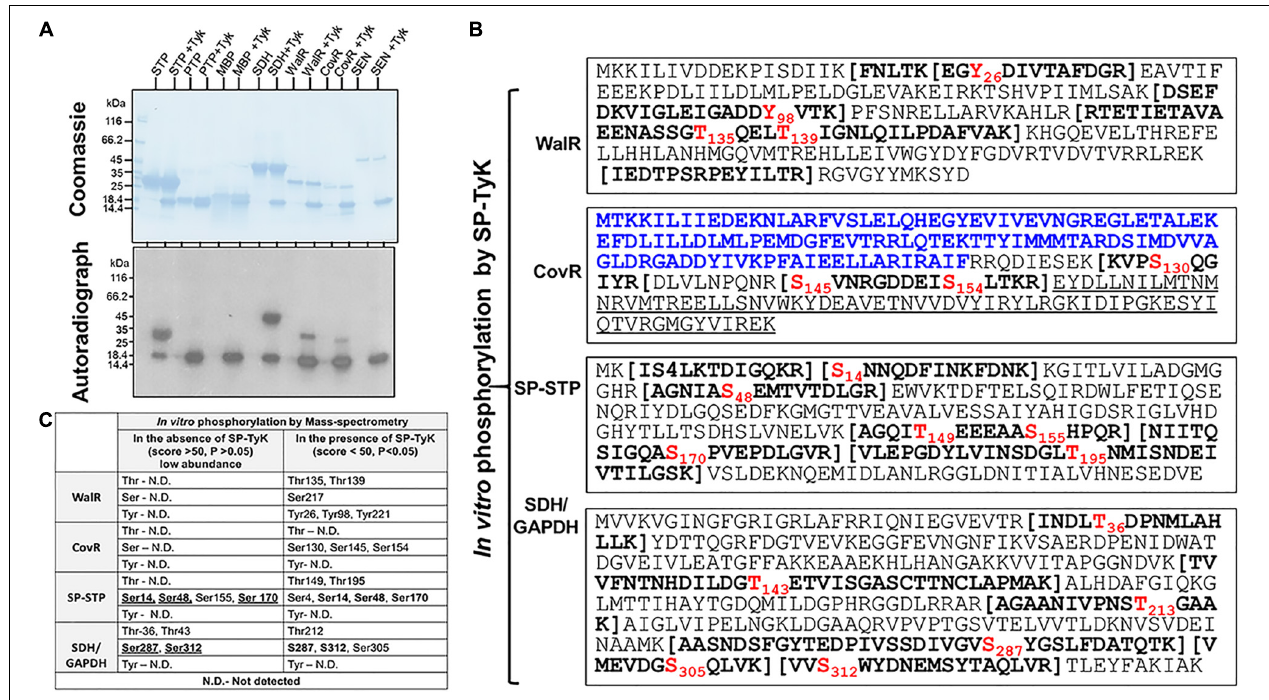
FIGURE 5 | SP-TyK-targeted in vitro substrates and their specific amino acid residues identification and biological relevance. (A) Identification of substrates by examining kinase activity of SP-TyK. SDS-PAGE-resolved individual proteins (SP-STP, SP-PTP, MBP, SDH, WalR, CovR, and SEN 1 µ g each) and corresponding autoradiographs show in vitro phosphorylation (as described in Figure 2 ) in the presence and absence of SP-TyK (Tyk, 0.6 µ g/reaction). Coomassie-stained SDS-PAGE gel with resolved protein bands depicts loading control for each protein. The corresponding autoradiograph shows the phosphorylated substrates only in the presence of SP-TyK. SP-TyK is autophosphorylated. SP-STP, SDH, CovR, and WalR show robust phosphorylation. SP-STP, S. pyogenes eukaryote-type Ser/Thr phosphatase; SP-PTP, S. pyogenes protein tyrosine phosphatase; MBP, myelin basic-protein; SDH, streptococcal surface dehydrogenase; WalR, cell wall metabolism response regulator; CovR, control of virulence regulator; SEN (streptococcal surface enolase). (B) Mass-spectrometry analysis of the SP-TyK-phosphorylated substrates was carried out as described in the “Materials and Methods” section. Peptide sequences with bold letters within the bracket(s) indicate tryptic peptides identified with one or more phosphorylated residues (shown in Red font). The N-terminal sequence of CovR in blue fonts (the N-terminal half) is a regulator-CovRR, and the underlined sequence in its C-terminal half is a DNA-binding region-CovRB). (C) Mass-spectrometry analysis of the WalR, CovR, SP-STP, and SDH/GAPDH after the phosphorylation reaction carried out in the absence and presence of SP-TyK enzyme using cold ATP. Detection of certain phosphorylated residues in the absence of SP-TyK at low abundance and at high score ( > 50) low probability ( p > 0.05) are treated as physiologically non-significant/background noise. Residues in bold fonts represent their detection before and after SP-TyK